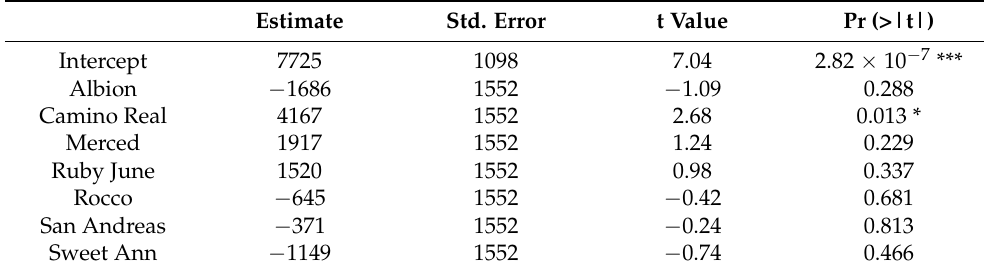
Table 1. Estimated average yield (kg ha − 1 ) from strawberry cultivars produced in the high tunnel with ‘Chandler’ as the base category.